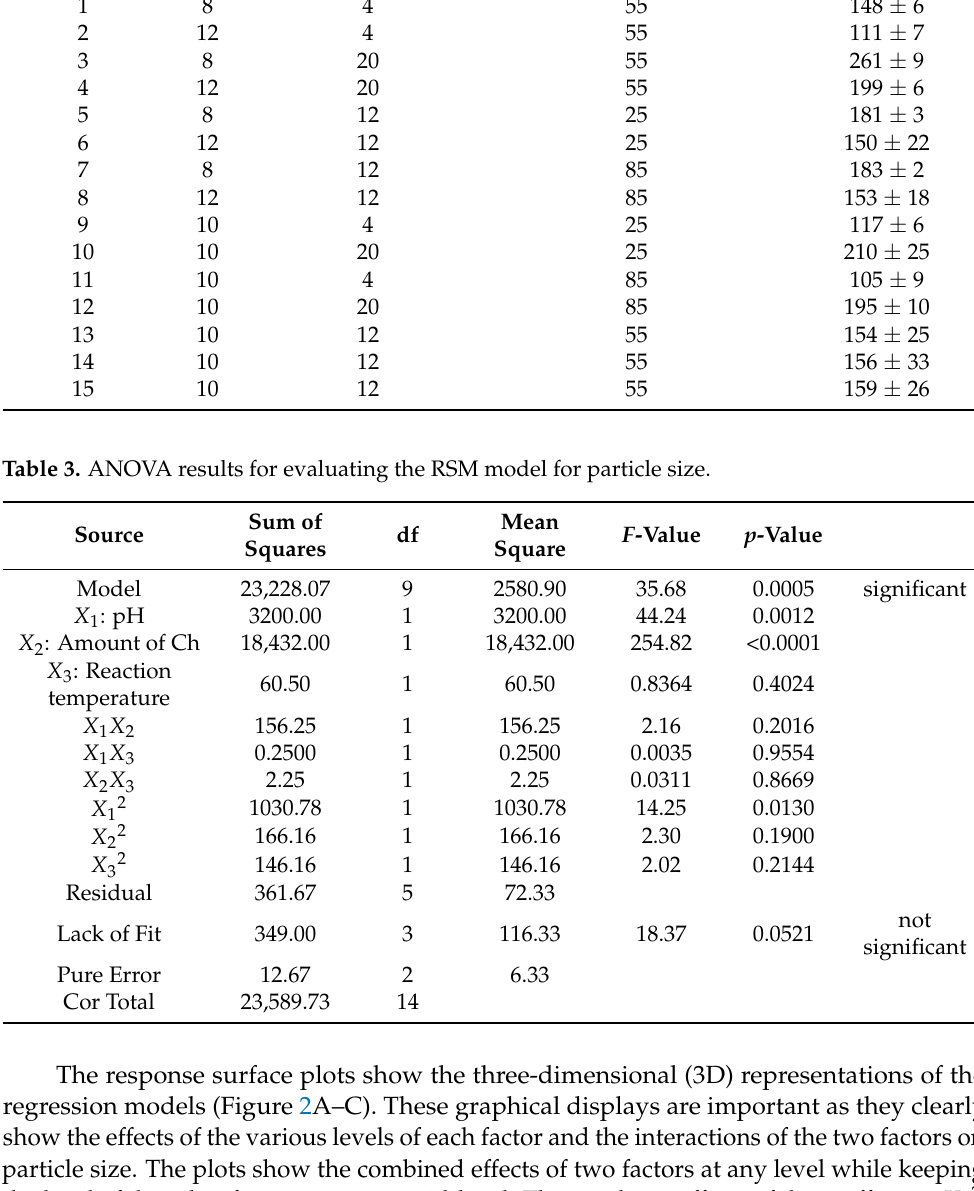
Table 2. Experimental variables and results in the Box–Behnken design ( n = 3). Std Order